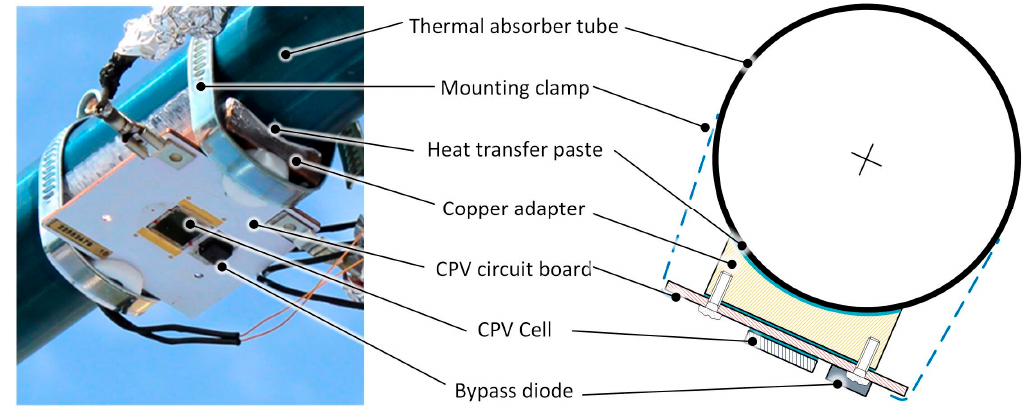
Figure 12. Photo and cross section of the CPV test cell attached to the thermal absorber tube.